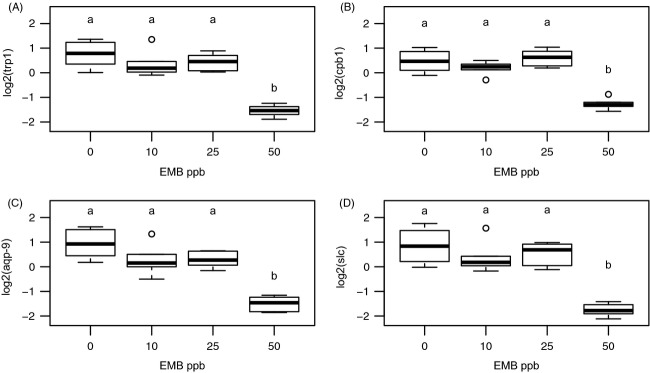
Pacific lice degradative enzyme and transporter suppression. RT-qPCR confirmed the downregulation at 50 ppb of degradative enzymes trypsin-1 (trp-1) and carboxypeptidase-1 (cpb-1), as well as transporters aquaporin-9 (aqp-9) and high-affinity copper transport protein (slc). Conditions that do not share a letter above the boxplot are significantly different from each other (Tukey HSD P ≤ 0.05). Boxplot displays median and interquartile range.